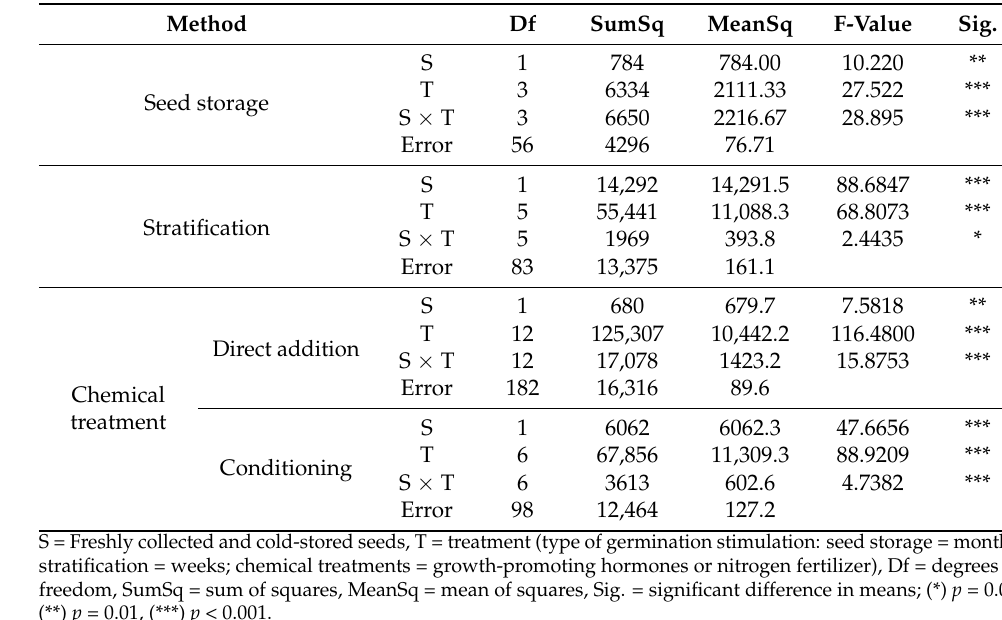
Table 1. Analysis of variance for the effect of dormancy-breaking methods on Ambrosia artemisiifo- lia seeds.